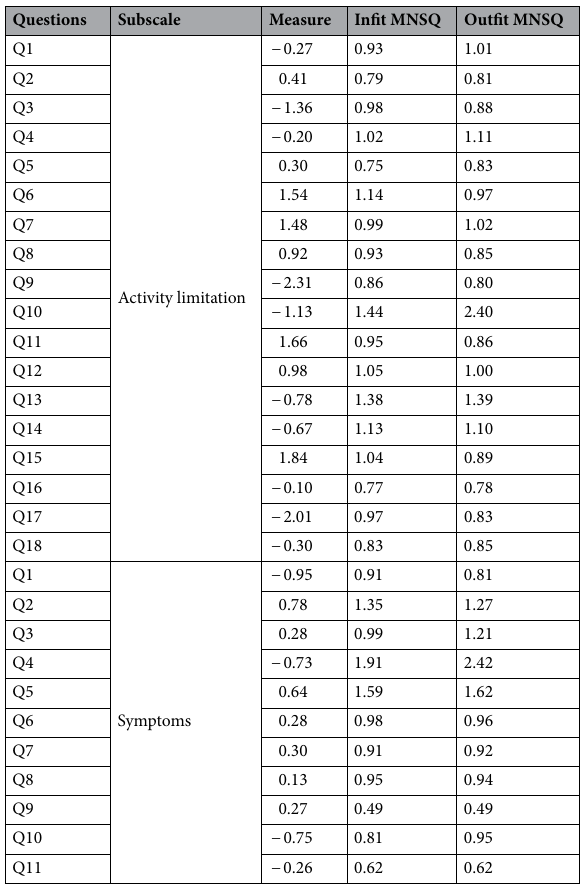
Table 4. Fit Statistics using Rasch Analysis with respective Subscales from Keratoconus Outcomes Research Questionnaire (KORQ). MNSQ mean